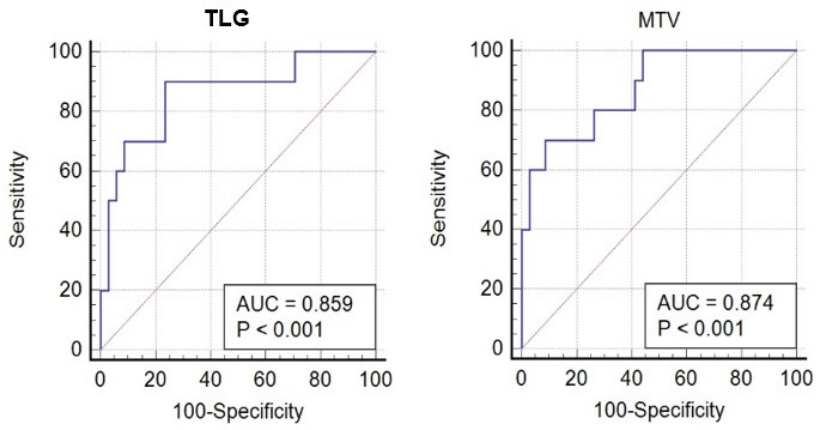
Figure 3. ROC analysis for MTV ( right ) and TLG ( left ) in CMR patients and n-CMR patients FIGO stages IB2-IIB.